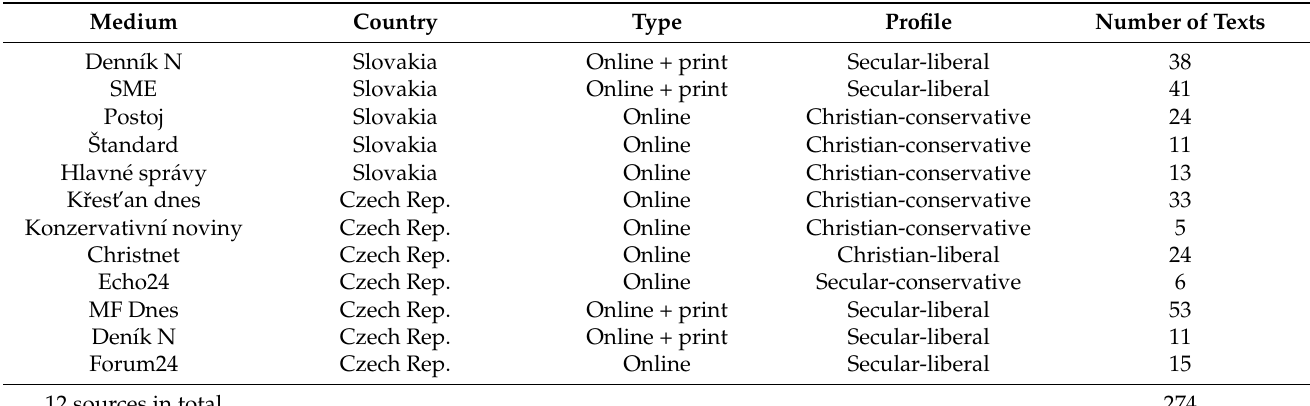
Table 1. Research